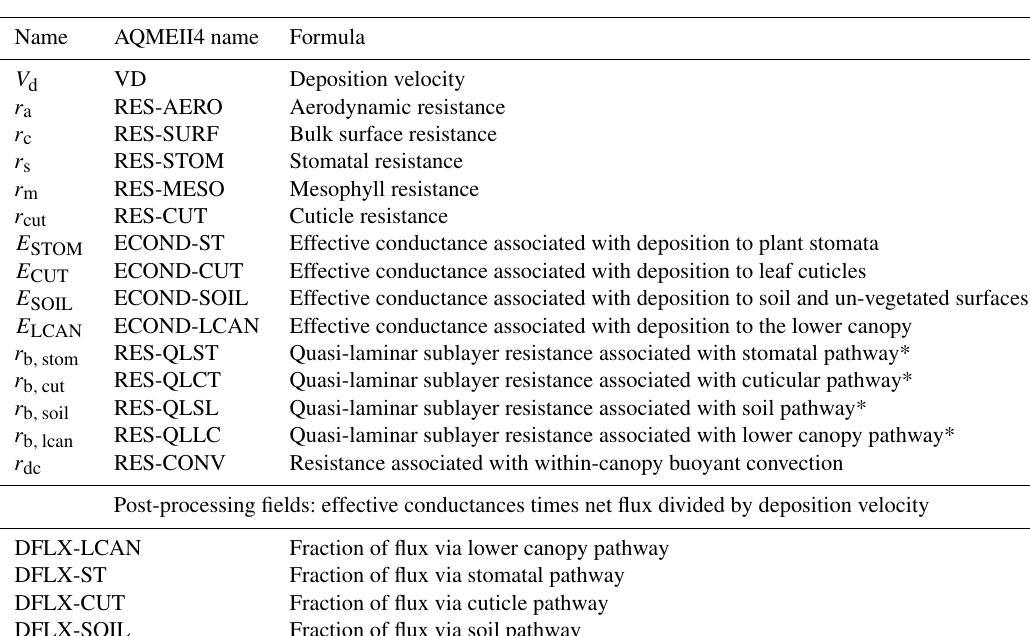
Table 4. AQMEII4 reported dry deposition diagnostic variables for gas-phase